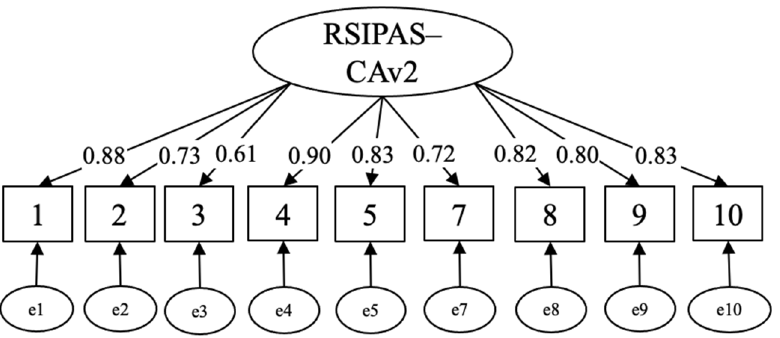
Figure 1. Baseline Hypothesized Model with Standardized Loadings. RSIPAS-CAv2 = Reli- gious/Spiritually Integrated Practice Assessment Scale-Client Attitudes, version 2.